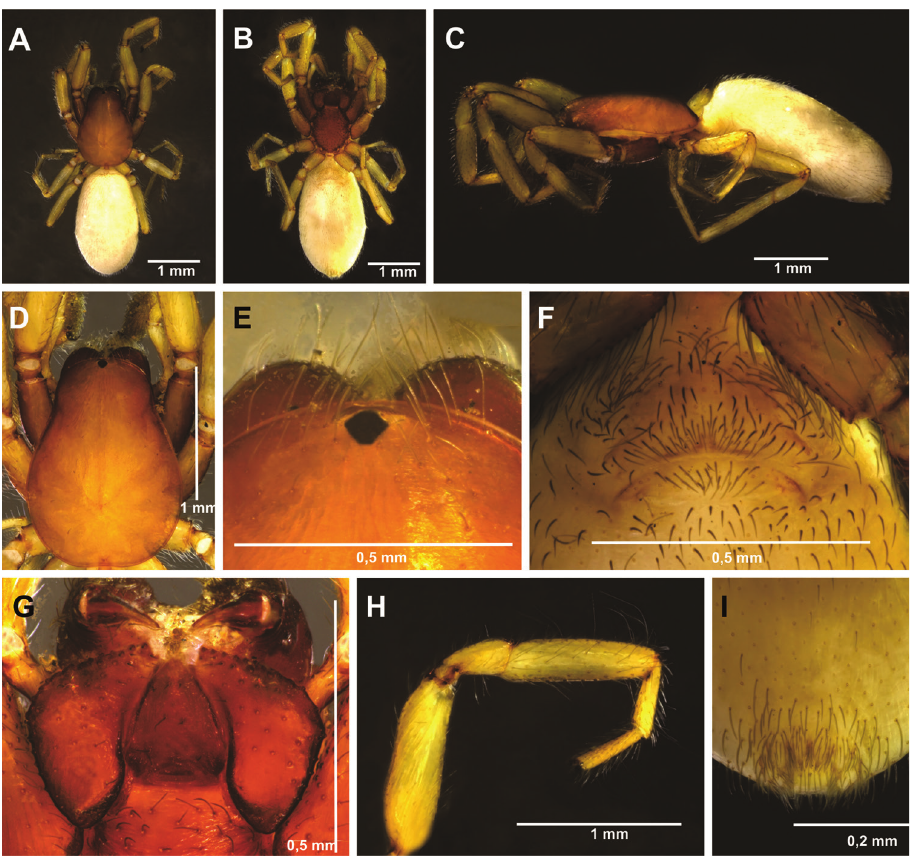
Figure 5. Tisentnops onix sp. n. , female holotype ( A–I ). A habitus, dorsal view B same, ventral view C same, lateral view D carapace, dorsal view E ocular area, dorsal view F abdomen, genital area, ventral view G mouthparts, ventral view H leg I, prolateral view, showing long hairs I spinnerets, ventral